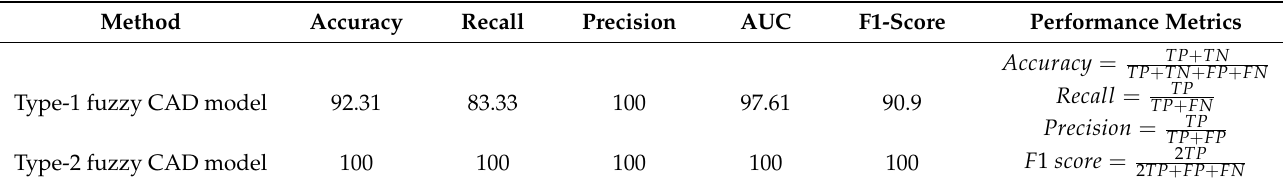
Table 3. Calculated performance metrics (%) of the designed fuzzy